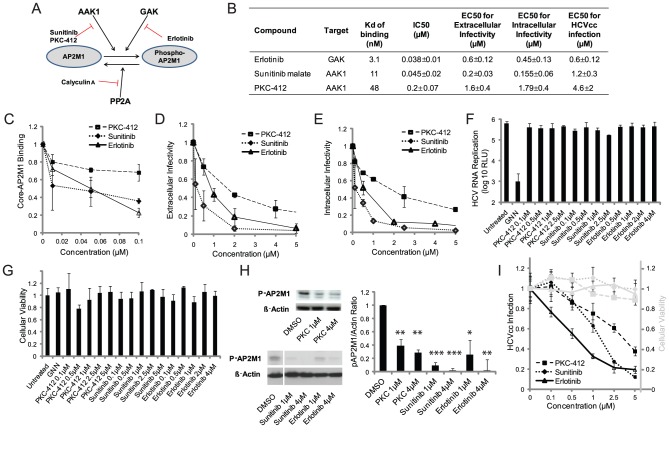
Pharmacological inhibition of core-AP2M1 binding and HCV assembly.A. AP2M1 regulators and the discovered inhibitors. B. The inhibitors' Kds of binding to AAK1 or GAK [78], IC50s for these compounds effect on core-AP2M1 binding, and EC50s for their effect on extracellular infectivity, intracellular infectivity, and viral infection with cell culture grown HCV (HCVcc). C. Inhibition of core-AP2M1 binding by the compounds measured by PCAs. D–G. Huh-7.5 cells electroporated with J6/JFH(p7-Rluc2A) were treated daily with either erlotinib, sunitinib or PKC-412 for 3 days. Supernatants and cell lysates were harvested at 72 hr and used to inoculate naive Huh-7.5 cells. Dose response curves of the inhibitors' effects on extracellular (D) and intracellular (E) infectivity relative to untreated controls. These compounds had no effect on HCV RNA replication (F) or cellular viability (G) by luciferase and AlamarBlue-based assays, respectively (GNN is a replication-defective polymerase mutant). H. The effect of the inhibitors on AP2M1 phosphorylation by Western analysis of cell lysates harvested following electroporation with J6/JFH(p7-Rluc2A) and treatment with the compounds in the presence of Calyculin A (Cal-A). Representative membranes blotted with anti-phopho-AP2M1 (p-AP2M1) and anti-actin antibodies, and quantitative analysis from 3 experiments are shown. Y axis represents pAP2M1/actin protein ratio relative to untreated controls. I. The inhibitors' effect on viral infection (black) and cellular viability (grey) in cells infected with HCVcc following 72 hr of daily treatment relative to untreated controls. Data represent means and s.d. (error bars) from at least three experiments in triplicates. RLU is relative light units. * p<0.05, ** p<0.01, *** p<0.001.